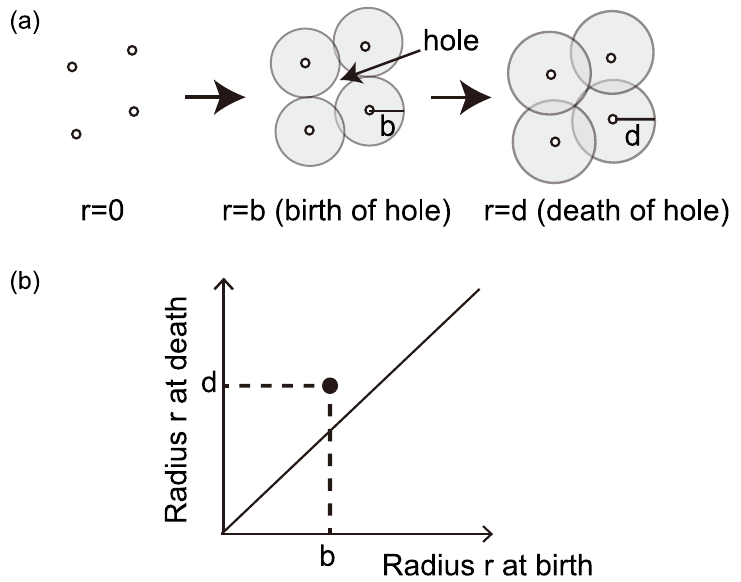
Fig 3. An example of persistent homology. (a) Filtration for a point cloud on a 2D space. (b) Persistence